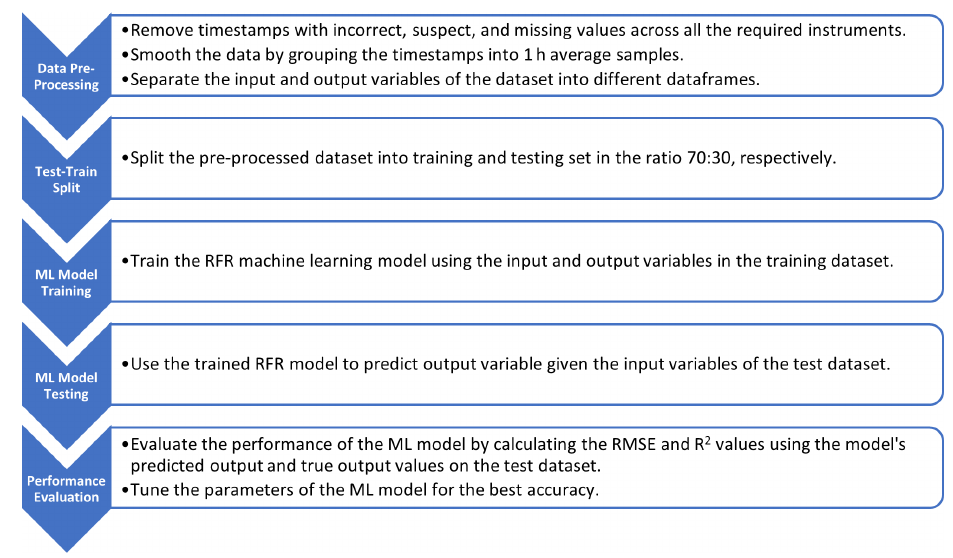
Figure A5. Workflow of a machine-learning-based correction model developed and used in this study.